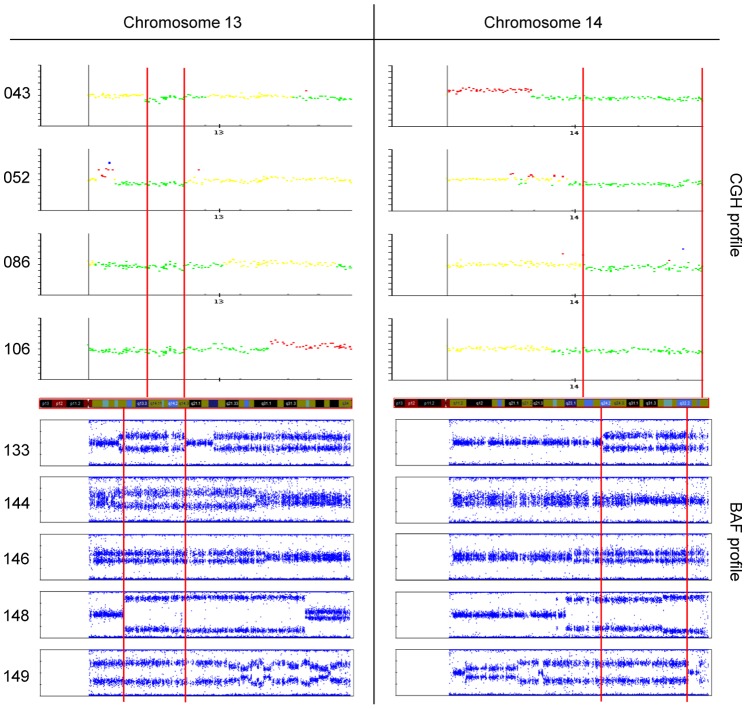
Genomic profiles in the training set.Upper panels: BAC-CGH profiles of BRCA2-mutant tumors showing gains in red, losses in green and modal copy number in yellow. Lower panels: BAF profiles of BRCA2-mutant tumors on Illumina SNP arrays. The boundaries of the common regions of deletion on chromosomes 13 and 14 are marked by vertical red lines.